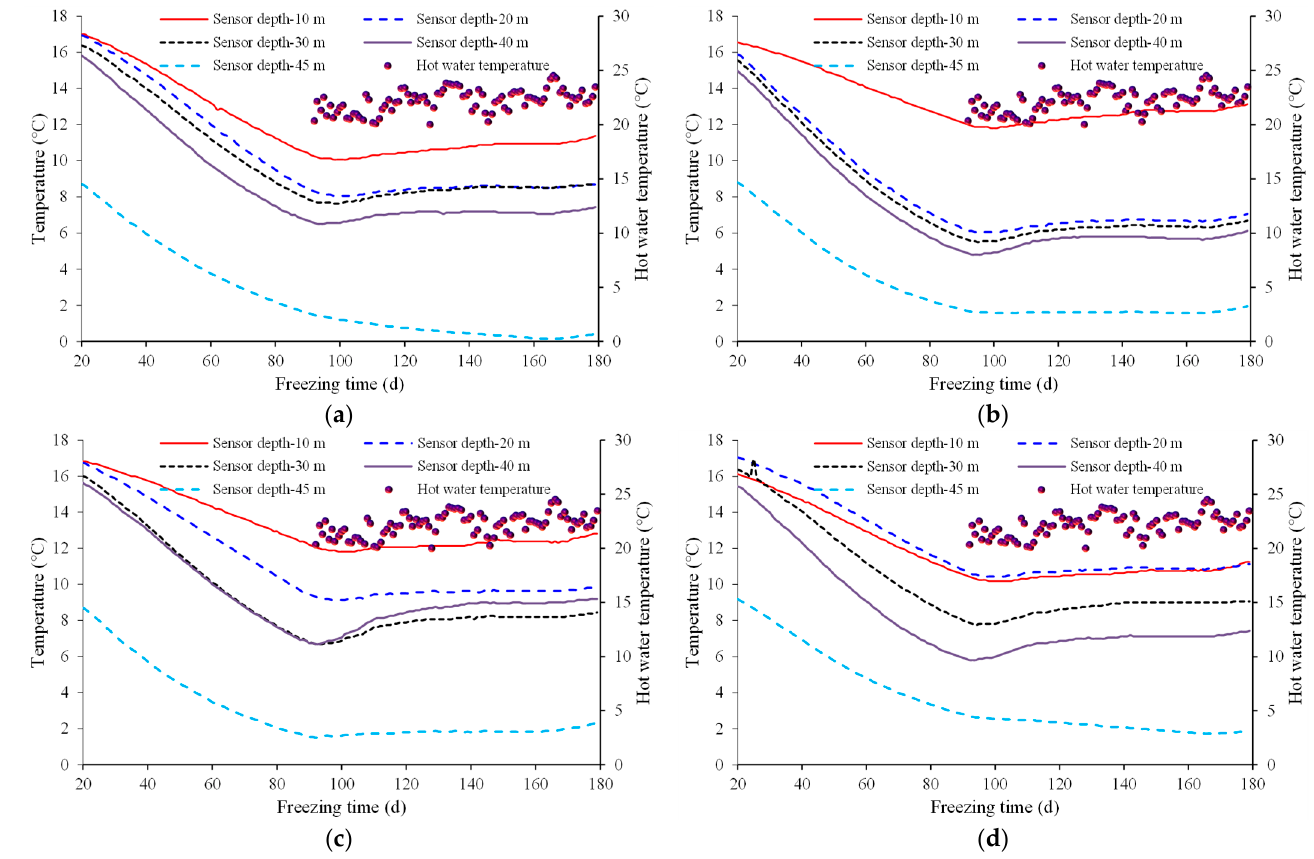
Figure 2. The curves of the hot water temperature and monitoring data obtained from K1, K2, K3, and K4. ( a ) Thermometer hole K1; ( b ) thermometer hole K2; ( c ) thermometer hole K3; ( d ) thermometer hole K4.